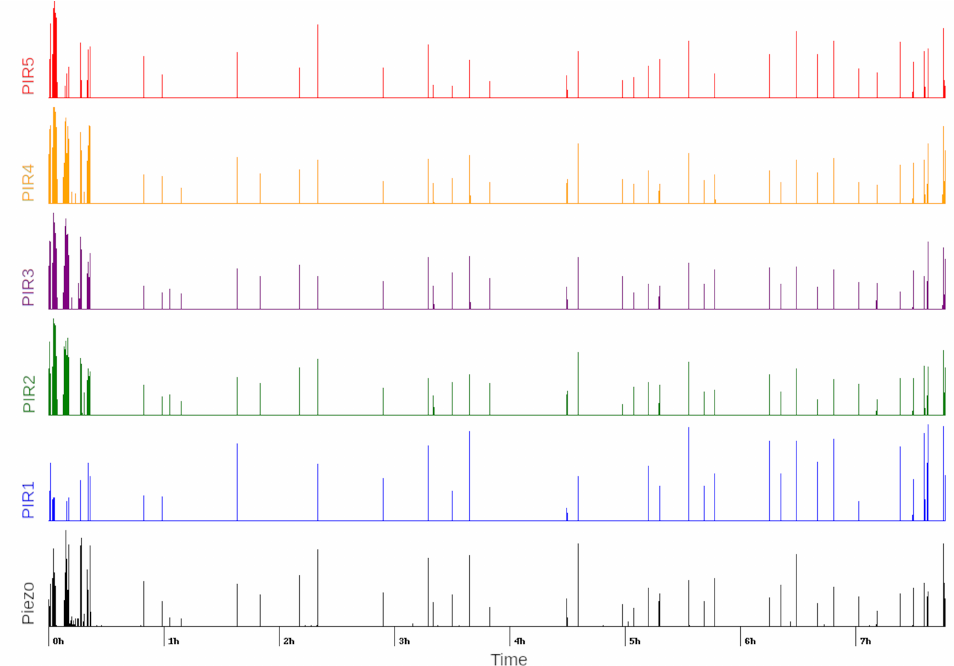
Figure 7. PIR and piezoelectric sensor activation (over 8 h of sleep).